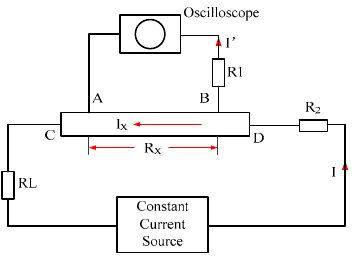
Figure 3. Schematic diagram of the four-electrode lead measurement of resistivity.